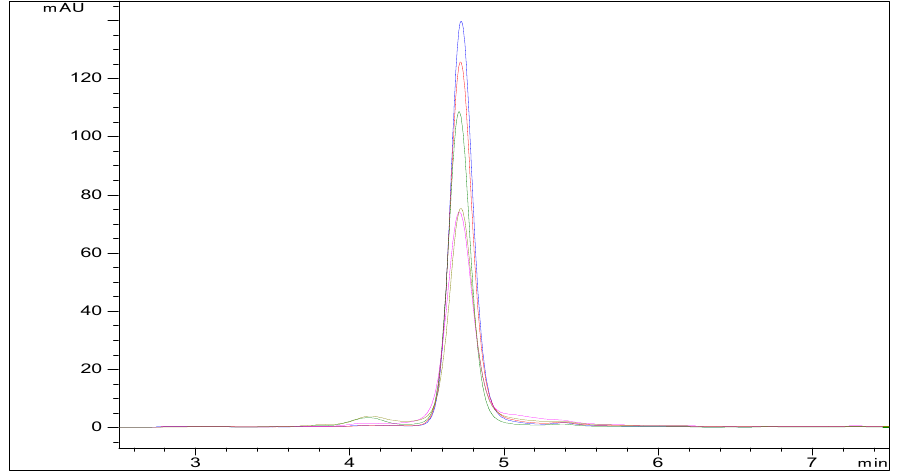
Figure A8. Representative chromatograms of Lf control sample and alkaline stress sample for two SEC columns: −− control sample and −− alkaline stress sample (Separation was performed on a Bi- oSep™-SEC-S 2000 column at 25 °C using 0.05 M sodium phosphate buffer containing 0.5 M NaCl (pH 7.0) as a mobile phase at a flow rate of 0.8 mL/min), −− control sample and −− alkaline stress sample (Separation was performed on an XBridge ® Protein BEH SEC 200 Ǻ column at 25 °C using a 0.2 M sodium phosphate buffer containing 0.1 M NaCl (pH 6.8) as a mobile phase at a flow rate of 0.86 mL/min).